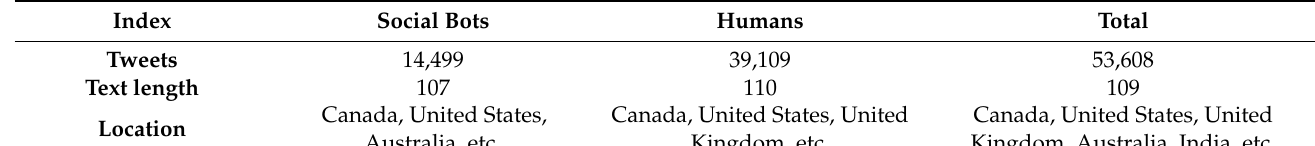
Table 1. COVID-19 pandemic topic tweet statistics.